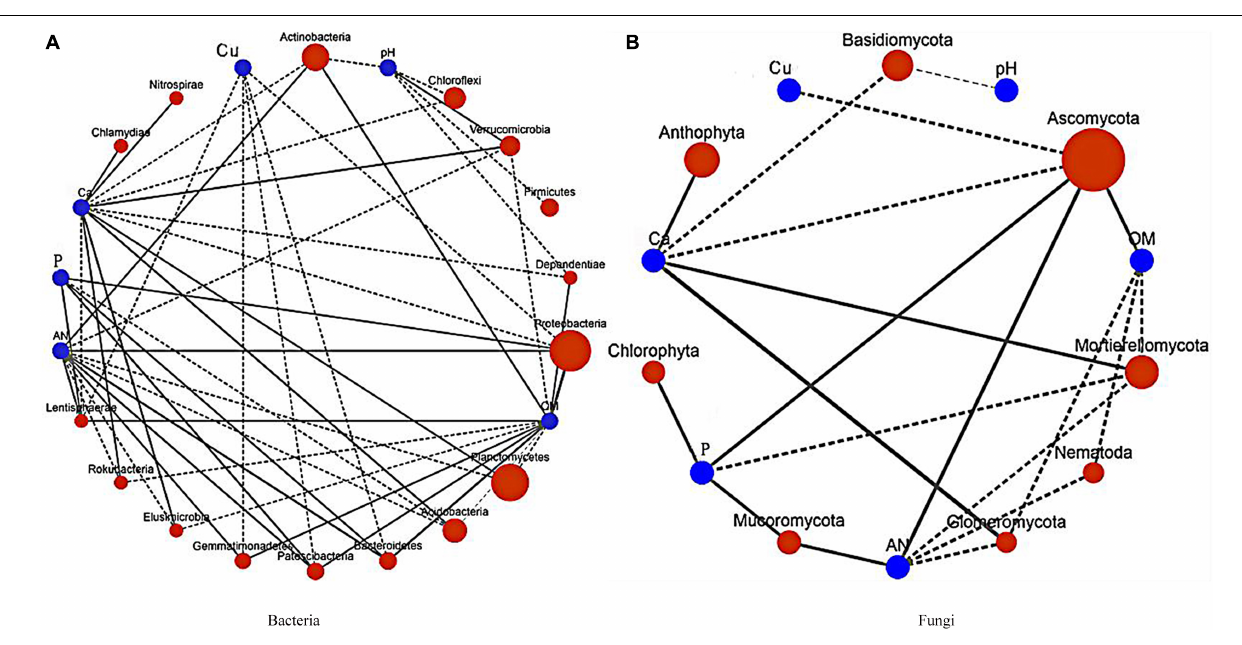
produced by this